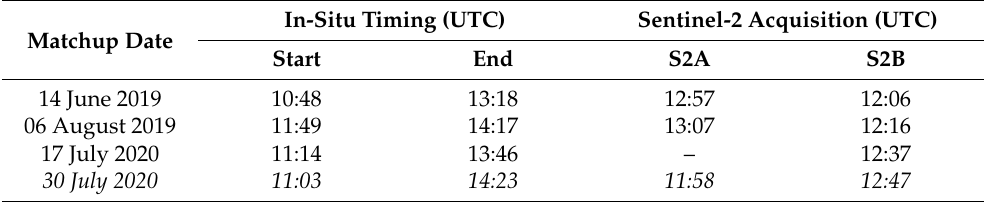
Table 2. Overview of timing of sampling in Adventfjorden that coincided with the acquisition of the Sentinel-2 satellite imagery. Start and End time for field campaigns was taken from CTD casts and corrected for local time. The time (UTC) is given for every matchup date. Note that the cal/val data obtained on 30 July 2020 (in italic) was later excluded from the calibration.